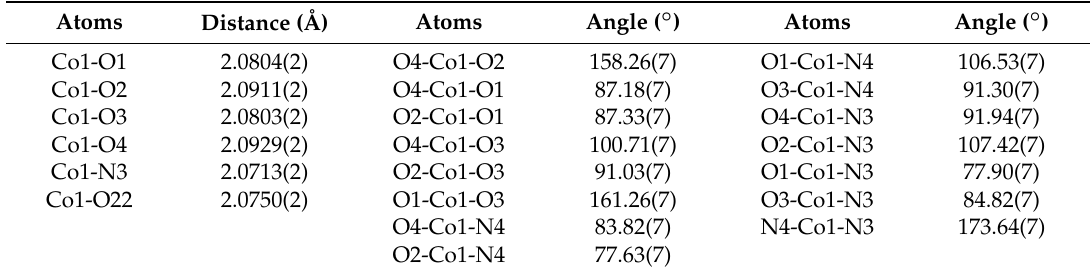
Table 1. Selected bond distances (Å) and angles ( ◦ ) of 1 .